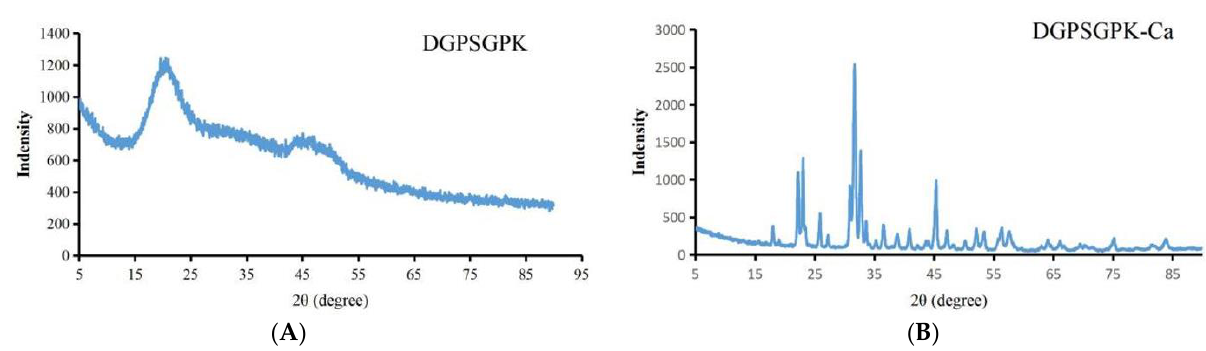
Figure 5. X-ray diffraction pattern of DGPSGPK ( A ) and DGPSGPK-Ca ( B